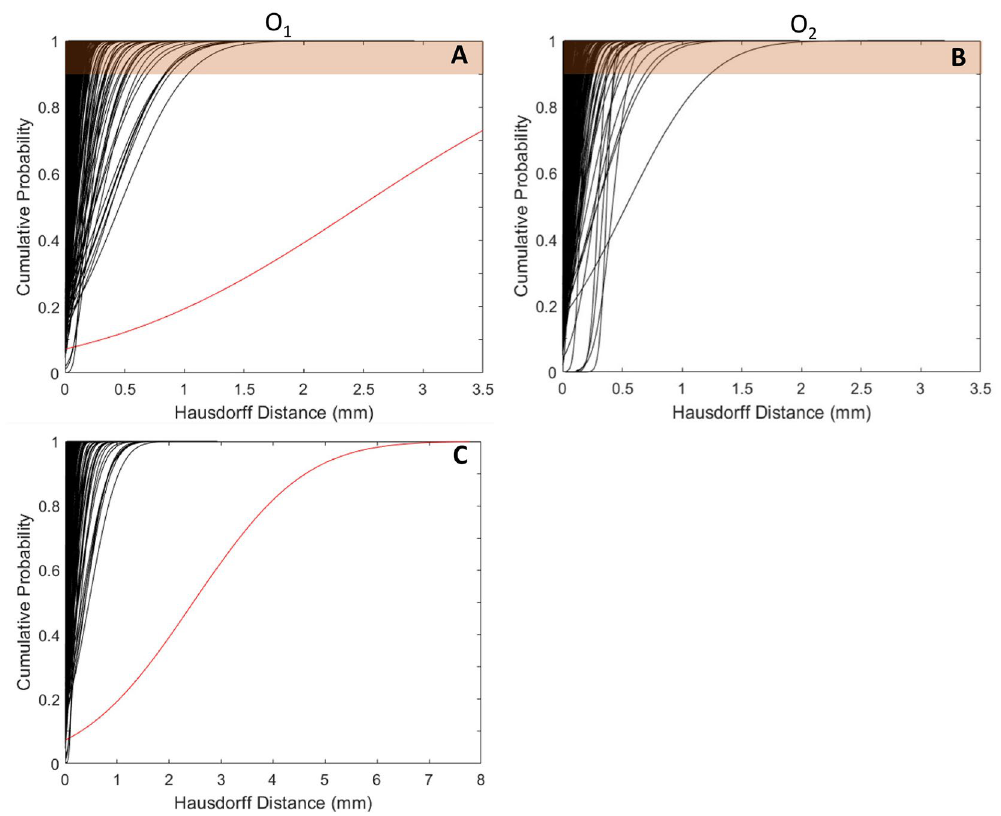
Figure 5. HD cumulative probability of operators O1 ( A ) and O2 ( B ) for each DIC mask registration (188 curves in total corresponding to 25 specimens, with 2 vertebrae each, tested in 2 disc conditions and 2 loading configurations, with exclusion of 3 tests in flexion). One DIC mask registration showed very large HD values compared to the others ( C